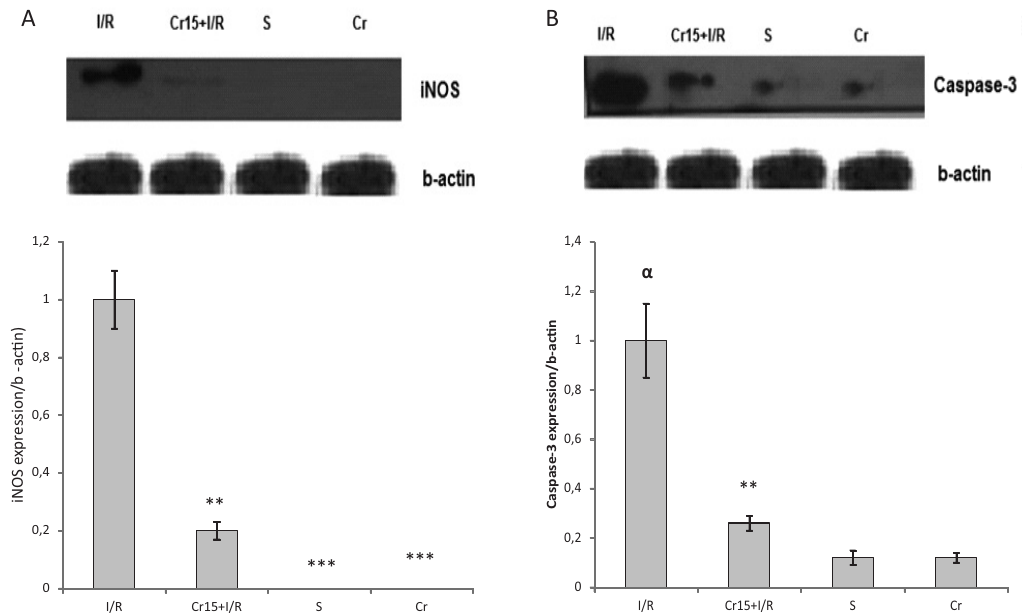
FIGURE 3 - Western blot analysis of iNOS (A) and caspase-3 (B) protein expression in the rat gastric mucosa following I/R injury. I/R: I/R injury animals, Cr15+I/R: rats pretreated with crocin (15 mg/kg, i.p.) 30 min before intervention, S: sham-operated group, Cr: crocin alone group (intact animals that received crocin at 15 mg/kg, i.p.). Crocin pretreatment caused a significant decrease in iNOS and caspase-3 protein expression. α P<0.001 indicates a significant increase versus sham-operated and crocin alone groups;**P<0.01 and ***P<0.01 versus control I/R injury group. Data are expressed as mean ± SEM. The protein levels were normalized to